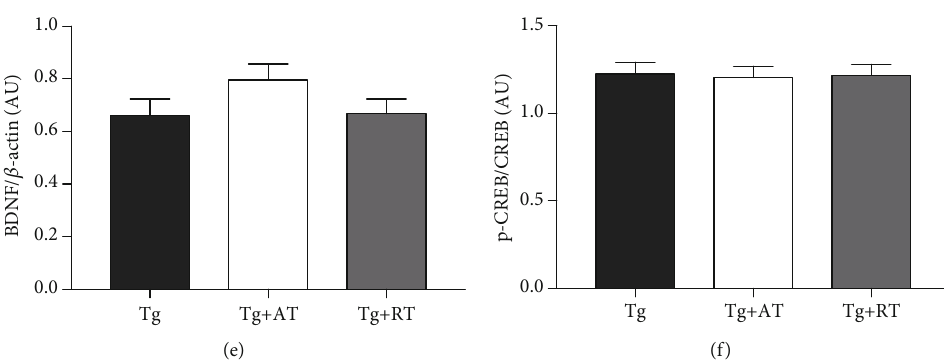
Figure 4: Reduced β -amyloid but unaltered CREB and BDNF in resistance-trained 3xTg-AD mice. (a) Representative immunoblots for amyloid precursor protein (APP) and β -amyloid probed in hippocampal homogenate. The shorter and longer exposure clearly revealed APP (110 to 85kDa) and A β oligomer (25 kDa) bands, respectively. (b) Amyloid precursor protein (APP) normalized to tubulin. (c) β - Amyloid expression normalized to tubulin. (d) Representative immunoblots for CREB and BDNF expression. (e) p-CREB normalized to total CREB. (f) BDNF expression normalized to β -actin. Data presented as mean ± SE . Tissues assayed from the nonexercised group (Tg), the aerobic-trained group (Tg+AT), or the resistance-trained group (Tg+RT) ( n = 10 /group). Di ff erences determined by one-way ANOVA. ∗ p < 0 : 05 and ∗∗ p < 0 : 01